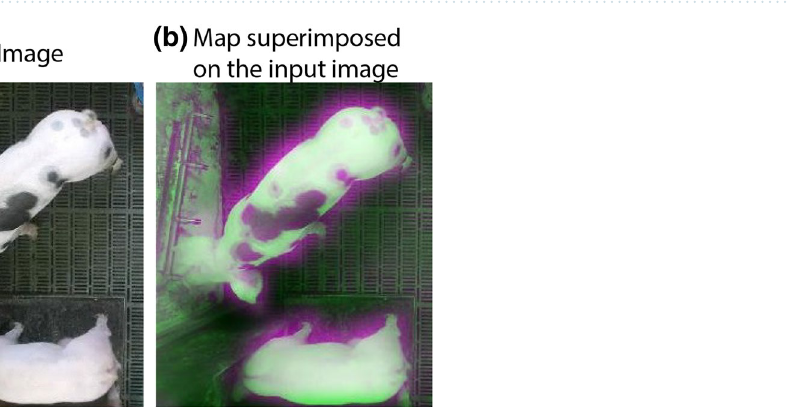
Figure 6. Architecture proposed for the automatic recognition of postures and drinking behaviour in commercially housed pigs. Each pig behaviour within the selected frames of our dataset was annotated by an animal behaviour scientist. The architecture above is capable of generating ( a ) group-level profiles for each pen; ( b ) individual profiles for each pig that include their postures, drinking and locomotion activities. Only pen-wise profiles were used to detect changes in behaviour at group-level during the feed-restrictions protocol period. The images in the figure were extracted from our dataset (‘Methods’ section).